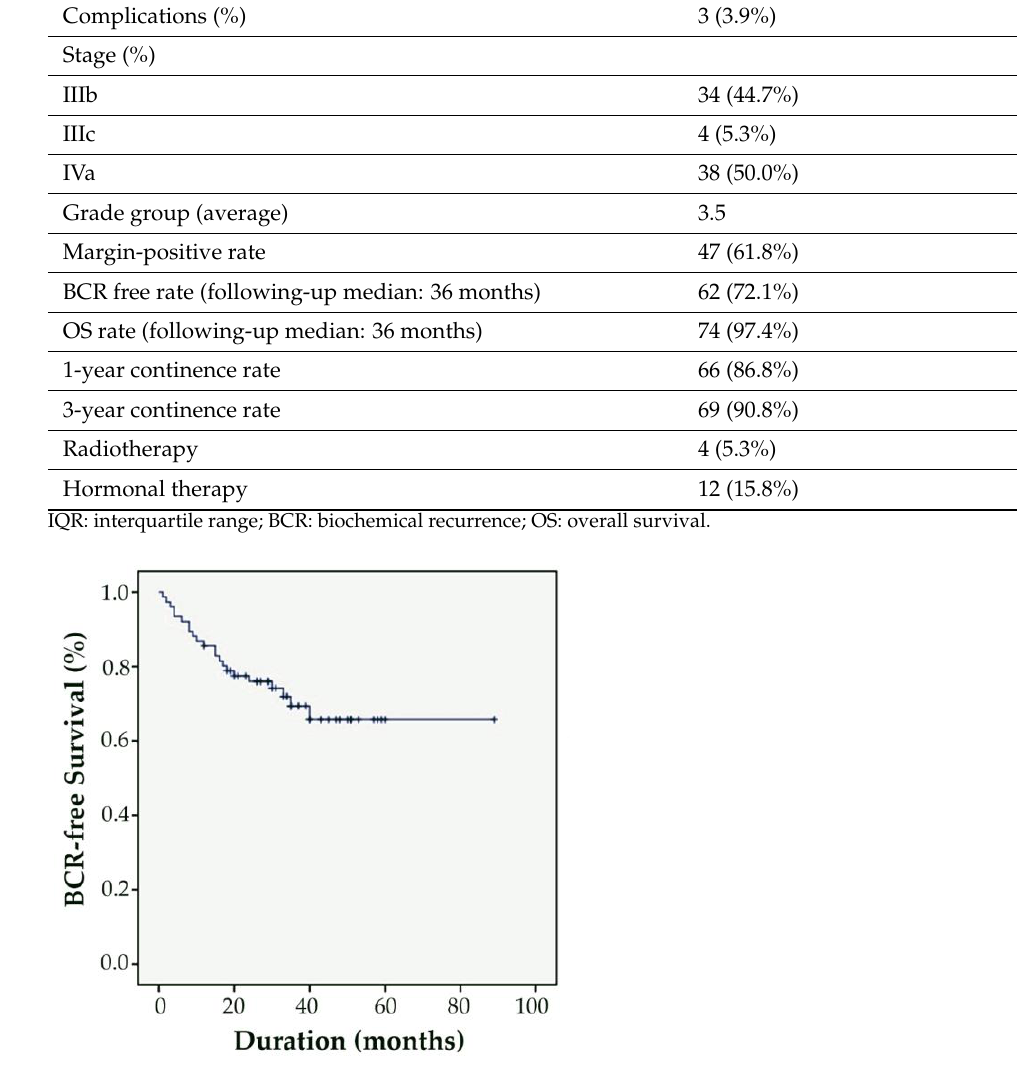
Figure 1. Kaplan-Meier analyses assessing time to BCR in patients with locally advanced prostate cancer treated with RARP and BPLND.